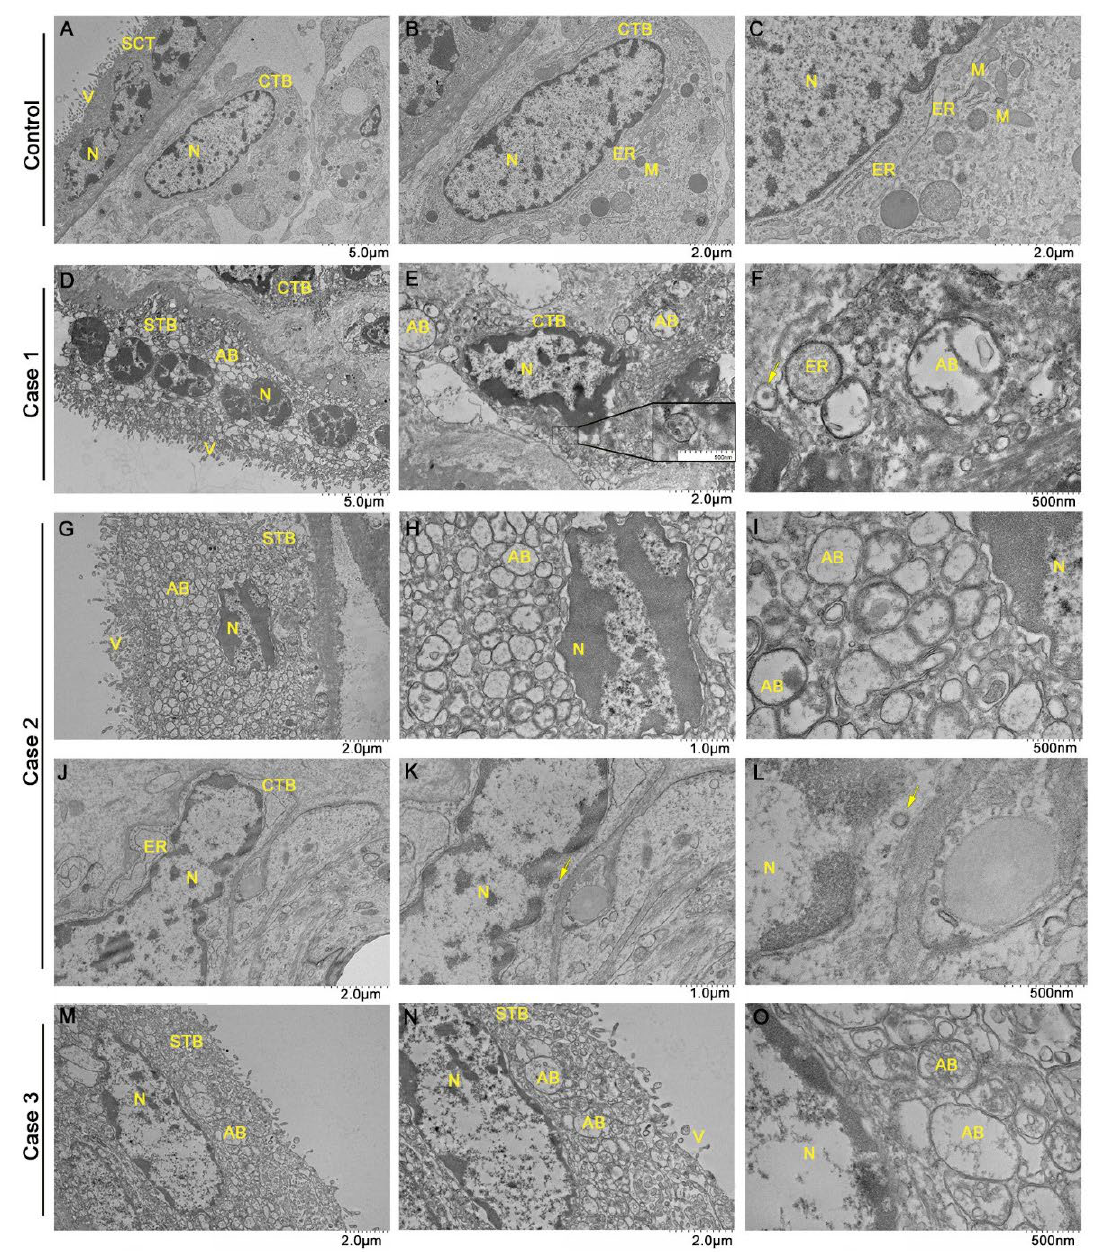
Figure 4. Ultrastructural changes in SARS-CoV-2 infected placental cells and presence of viral particles. ( A – C ) Prepandemic control placental sample with normal-looking syncytiotrophoblast (STB) and cytotrophoblast (CTB) cells. ( D – O ) Samples from infected placentas, with altered morphology. ( E ) Higher magnification of the viral cluster area. (N) nucleus; (M) mitochondria; (ER) endoplasmic reticulum; (V) villi; (AB) apoptotic bodies. Arrowheads indicate viral particles of approximately 70 nm, compatible with the size of SARS-CoV-2.